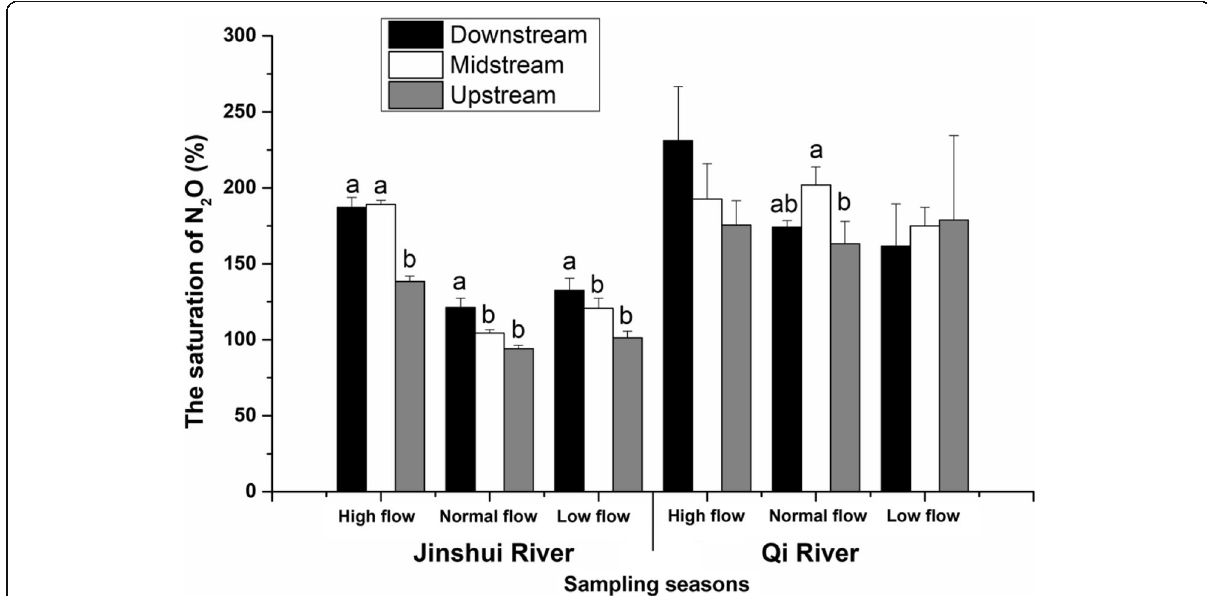
Fig. 3 The saturation of N 2 O in the Jinshui River and Qi River. Vertical bar denote SE of triplicate samples. Different letters indicate significant differences among sampling areas by linear mixed modeling ( P <